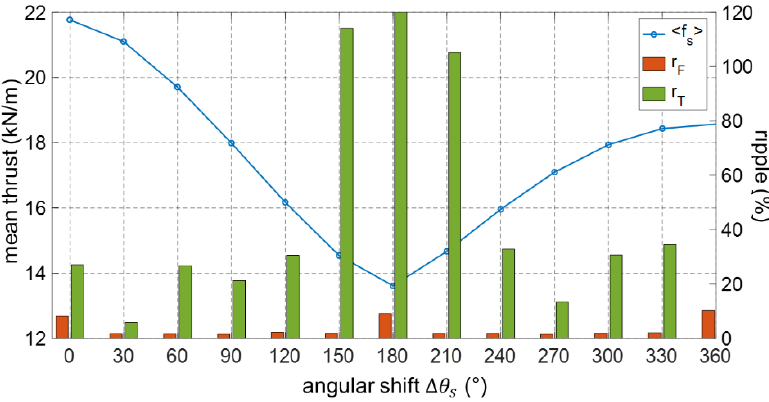
Figure 6. Thrust and torque performances as functions of the angular shift Δ𝜃 𝑠 (conf. B).